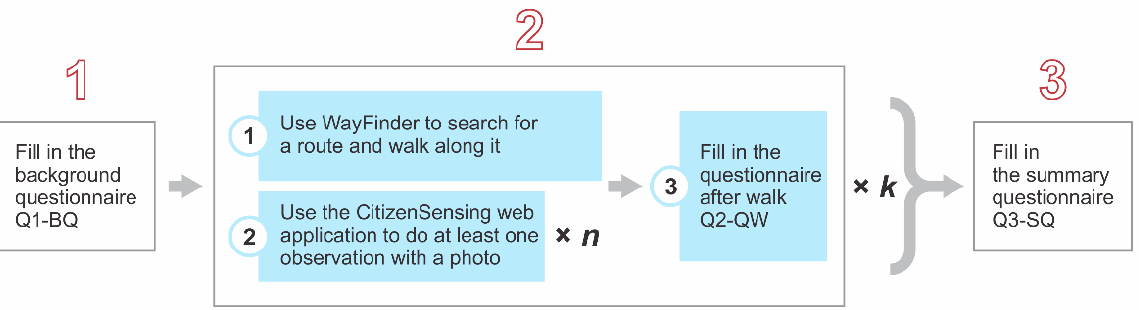
Figure 3. The three stages in the data collection.